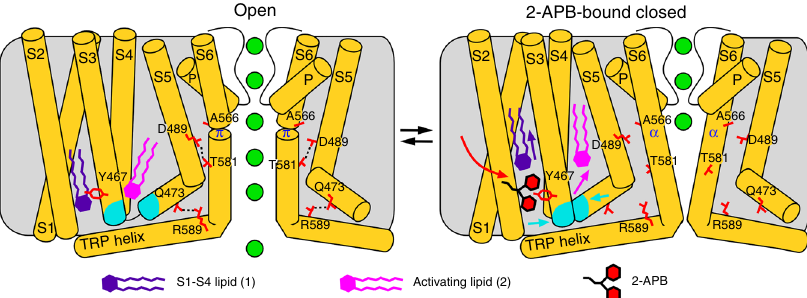
Fig. 10 Mechanism of TRPV6 inhibition by 2-APB. Cartoons represent the structural changes that start with binding (red arrow) of 2-APB, which displaces the S1 – S4 lipid (lipid 1, purple) and promotes formation of the hydrophobic cluster (cyan). Formation of the cluster displaces the activating lipid (lipid 2, pink) and eliminates hydrogen bonds (dashed lines), which stabilize the open state by energetically compensating the unfavorable α -to- π helical transition in S6. As S6 turns α -helical, the channel closes and its pore becomes impermeable to ions (green spheres)